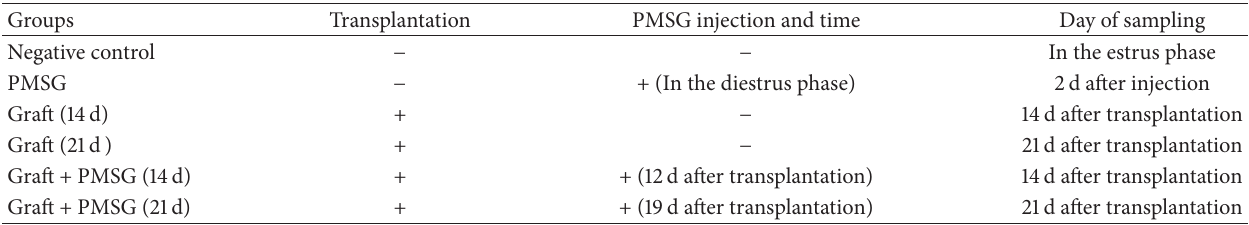
Table 1: Groups and procedures for evaluation of superovulation effect on follicular development after autologous ovarian transplantation in